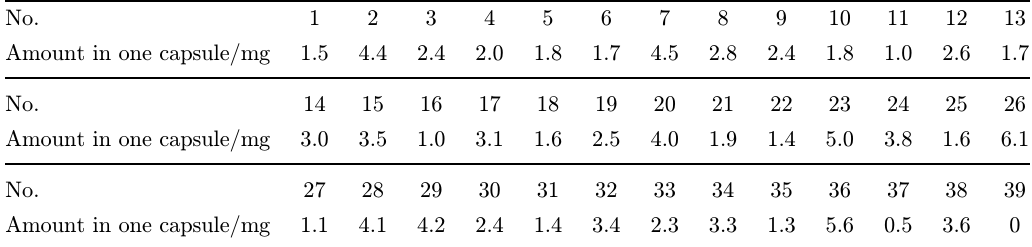
Table 2. Positive samples with nifedipine and negative samples without nifedipine.